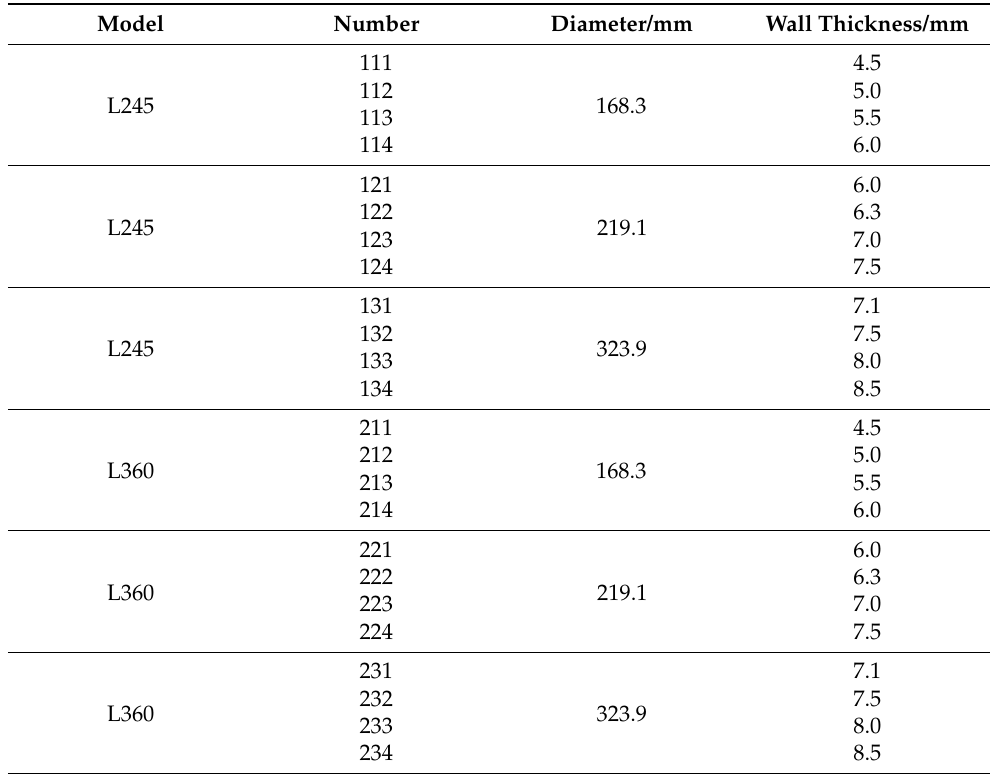
Figure 11. Pipeline strain cloud diagram. Table 2. Pipeline